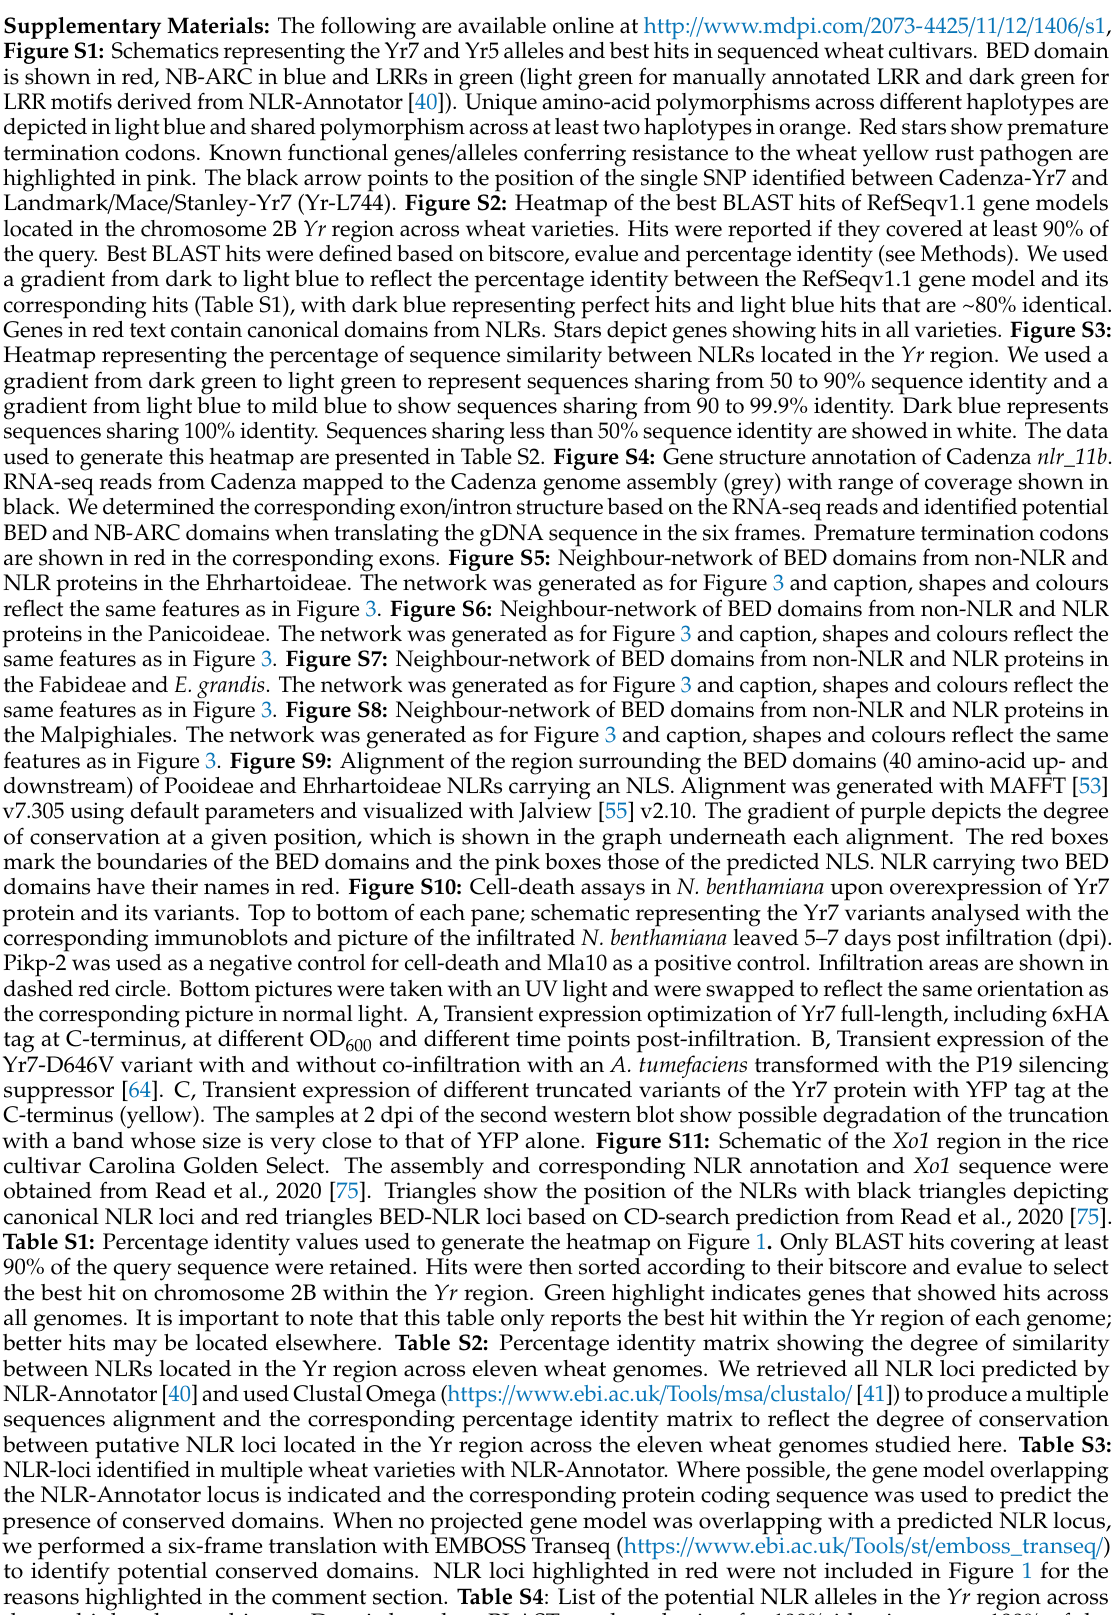
Figure S1: Schematics representing the Yr7 and Yr5 alleles and best hits in sequenced wheat cultivars. BED domain is shown in red, NB-ARC in blue and LRRs in green (light green for manually annotated LRR and dark green for LRR motifs derived from NLR-Annotator [40]). Unique amino-acid polymorphisms across di ff erent haplotypes are depicted in light blue and shared polymorphism across at least two haplotypes in orange. Red stars show premature termination codons. Known functional genes / alleles conferring resistance to the wheat yellow rust pathogen are highlighted in pink. The black arrow points to the position of the single SNP identified between Cadenza-Yr7 and Landmark / Mace / Stanley-Yr7 (Yr-L744). Figure S2: Heatmap of the best BLAST hits of RefSeqv1.1 gene models located in the chromosome 2B Yr region across wheat varieties. Hits were reported if they covered at least 90% of the query. Best BLAST hits were defined based on bitscore, evalue and percentage identity (see Methods). We used a gradient from dark to light blue to reflect the percentage identity between the RefSeqv1.1 gene model and its corresponding hits (Table S1), with dark blue representing perfect hits and light blue hits that are ~80% identical. Genes in red text contain canonical domains from NLRs. Stars depict genes showing hits in all varieties. Figure S3: Heatmap representing the percentage of sequence similarity between NLRs located in the Yr region. We used a gradient from dark green to light green to represent sequences sharing from 50 to 90% sequence identity and a gradient from light blue to mild blue to show sequences sharing from 90 to 99.9% identity. Dark blue represents sequences sharing 100% identity. Sequences sharing less than 50% sequence identity are showed in white. The data used to generate this heatmap are presented in Table S2. Figure S4: Gene structure annotation of Cadenza nlr_11b . RNA-seq reads from Cadenza mapped to the Cadenza genome assembly (grey) with range of coverage shown in black. We determined the corresponding exon / intron structure based on the RNA-seq reads and identified potential BED and NB-ARC domains when translating the gDNA sequence in the six frames. Premature termination codons are shown in red in the corresponding exons. Figure S5: Neighbour-network of BED domains from non-NLR and NLR proteins in the Ehrhartoideae. The network was generated as for Figure 3 and caption, shapes and colours reflect the same features as in Figure 3. Figure S6: Neighbour-network of BED domains from non-NLR and NLR proteins in the Panicoideae. The network was generated as for Figure 3 and caption, shapes and colours reflect the same features as in Figure 3. Figure S7: Neighbour-network of BED domains from non-NLR and NLR proteins in the Fabideae and E. grandis . The network was generated as for Figure 3 and caption, shapes and colours reflect the same features as in Figure 3. Figure S8: Neighbour-network of BED domains from non-NLR and NLR proteins in the Malpighiales. The network was generated as for Figure 3 and caption, shapes and colours reflect the same features as in Figure 3. Figure S9: Alignment of the region surrounding the BED domains (40 amino-acid up- and downstream) of Pooideae and Ehrhartoideae NLRs carrying an NLS. Alignment was generated with MAFFT [53] v7.305 using default parameters and visualized with Jalview [55] v2.10. The gradient of purple depicts the degree of conservation at a given position, which is shown in the graph underneath each alignment. The red boxes mark the boundaries of the BED domains and the pink boxes those of the predicted NLS. NLR carrying two BED domains have their names in red. Figure S10: Cell-death assays in N. benthamiana upon overexpression of Yr7 protein and its variants. Top to bottom of each pane; schematic representing the Yr7 variants analysed with the corresponding immunoblots and picture of the infiltrated N. benthamiana leaved 5–7 days post infiltration (dpi). Pikp-2 was used as a negative control for cell-death and Mla10 as a positive control. Infiltration areas are shown in dashed red circle. Bottom pictures were taken with an UV light and were swapped to reflect the same orientation as the corresponding picture in normal light. A, Transient expression optimization of Yr7 full-length, including 6xHA tag at C-terminus, at di ff erent OD 600 and di ff erent time points post-infiltration. B, Transient expression of the Yr7-D646V variant with and without co-infiltration with an A. tumefaciens transformed with the P19 silencing suppressor [64]. C, Transient expression of di ff erent truncated variants of the Yr7 protein with YFP tag at the C-terminus (yellow). The samples at 2 dpi of the second western blot show possible degradation of the truncation with a band whose size is very close to that of YFP alone. Figure S11: Schematic of the Xo1 region in the rice cultivar Carolina Golden Select. The assembly and corresponding NLR annotation and Xo1 sequence were obtained from Read et al., 2020 [75]. Triangles show the position of the NLRs with black triangles depicting canonical NLR loci and red triangles BED-NLR loci based on CD-search prediction from Read et al., 2020 [75]. Table S1: Percentage identity values used to generate the heatmap on Figure 1 . Only BLAST hits covering at least 90% of the query sequence were retained. Hits were then sorted according to their bitscore and evalue to select the best hit on chromosome 2B within the Yr region. Green highlight indicates genes that showed hits across all genomes. It is important to note that this table only reports the best hit within the Yr region of each genome; better hits may be located elsewhere. Table S2: Percentage identity matrix showing the degree of similarity between NLRs located in the Yr region across eleven wheat genomes. We retrieved all NLR loci predicted by NLR-Annotator [40] and used Clustal Omega (https: // www.ebi.ac.uk / Tools / msa / clustalo / [41]) to produce a multiple sequences alignment and the corresponding percentage identity matrix to reflect the degree of conservation between putative NLR loci located in the Yr region across the eleven wheat genomes studied here. Table S3: NLR-loci identified in multiple wheat varieties with NLR-Annotator. Where possible, the gene model overlapping the NLR-Annotator locus is indicated and the corresponding protein coding sequence was used to predict the presence of conserved domains. When no projected gene model was overlapping with a predicted NLR locus, we performed a six-frame translation with EMBOSS Transeq (https: // www.ebi.ac.uk / Tools / st / emboss_transeq / ) to identify potential conserved domains. NLR loci highlighted in red were not included in Figure 1 for the reasons highlighted in the comment section. Table S4 : List of the potential NLR alleles in the Yr region across the multiple wheat cultivars. Data is based on BLAST results selecting for 100% identity across 100% of the query sequence. Table S5: Downloaded proteomes for the study and associated BUSCO scores based on the Viridiplantae and Embryophyta datasets. We retained proteomes that obtained a percentage completeness greater than 85% for both Viridiplantae and Embryophyta datasets from Embryophyta plants and greater